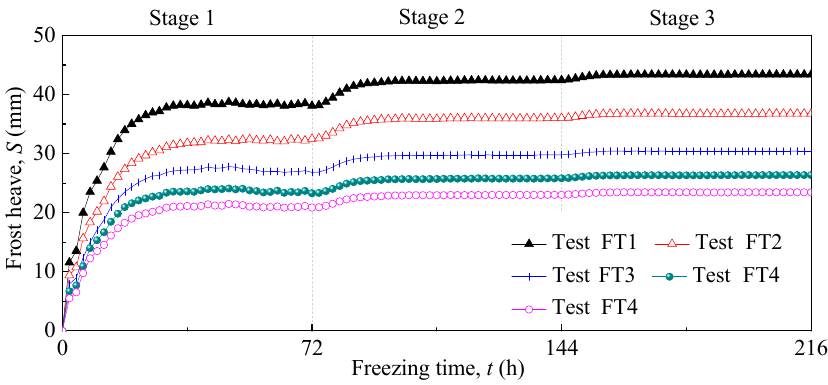
Figure 5. Frost heave effects of soil samples at different heights in tests FT1–FT5.